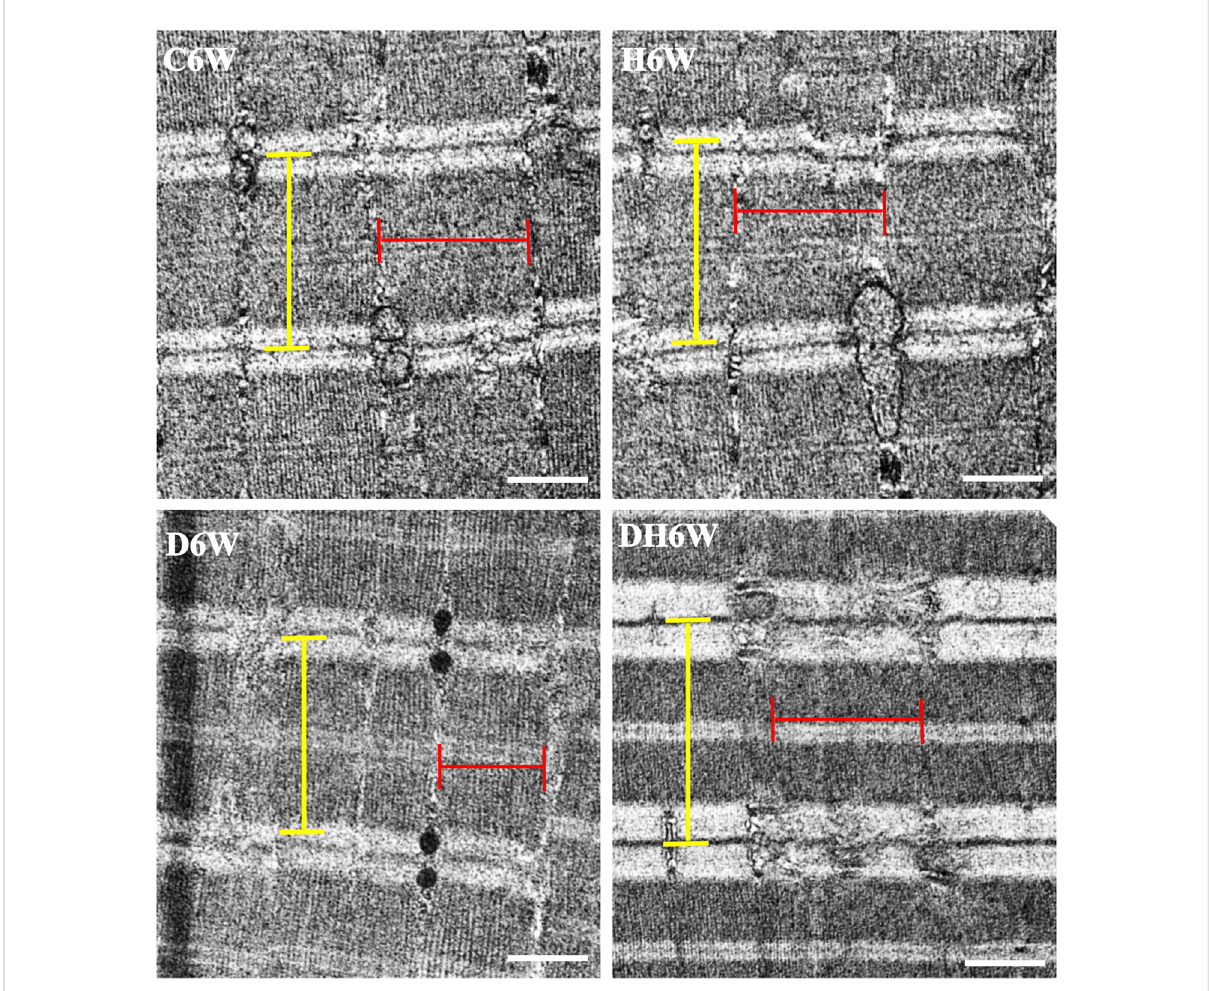
FIGURE 6 Representative electron photomicrographs of longitudinal sections muscle fi bers in different groups in a long-term experiment. Note the decreasedmuscle fi brilsize(indicatedbyredline)inD6WcomparedtoC6W.Themuscle fi brilsizewasincreasedinsizeinDH6WcomparedtoD6W, anditiscomparabletothatinC6WandH6Wgroups.Thedimensionofthesarcomere(indicatedbytheyellowline)isdecreasedinD6Wcomparedto C6W and it is increased in DH6W. Scale bar = 500